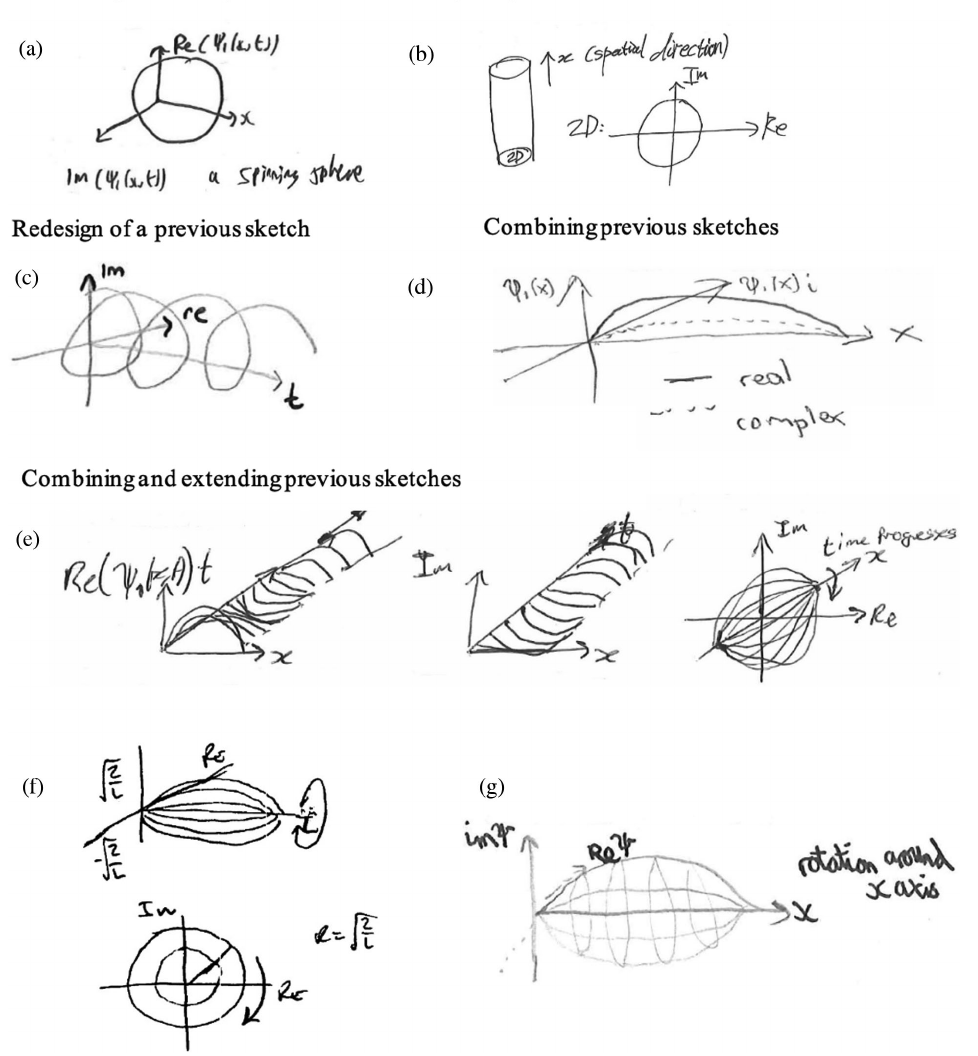
FIG. 7. Examples of students ’ sketches illustrating the different ways that previous sketches were extended, redesigned, and combined in the invention task (task D in Fig.